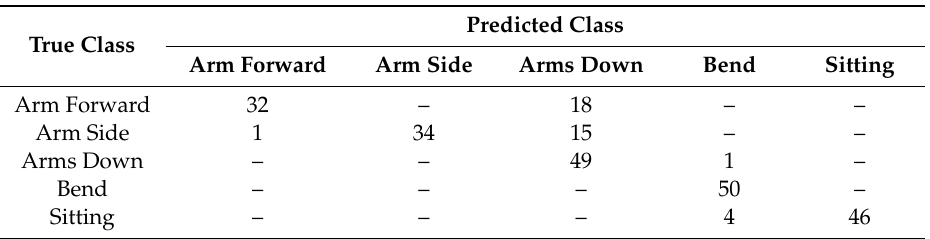
Table 14. Confusion matrix generated from implementing the Soft Voting approach to prediction selection for two corner TISs.